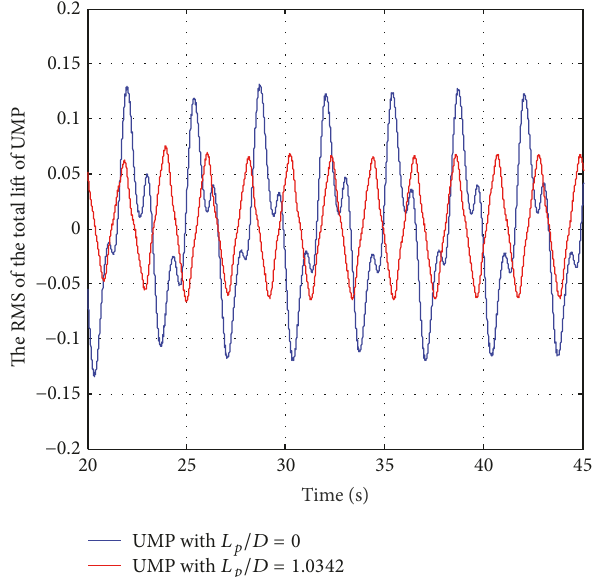
Figure 23: The RMS of total lift coefficient of the UMP with plate and the bare